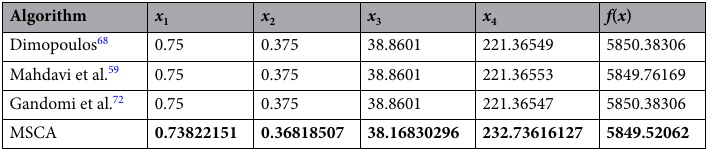
Table 23. The best solution for pressure vessel design problem on version II. Significant values are in